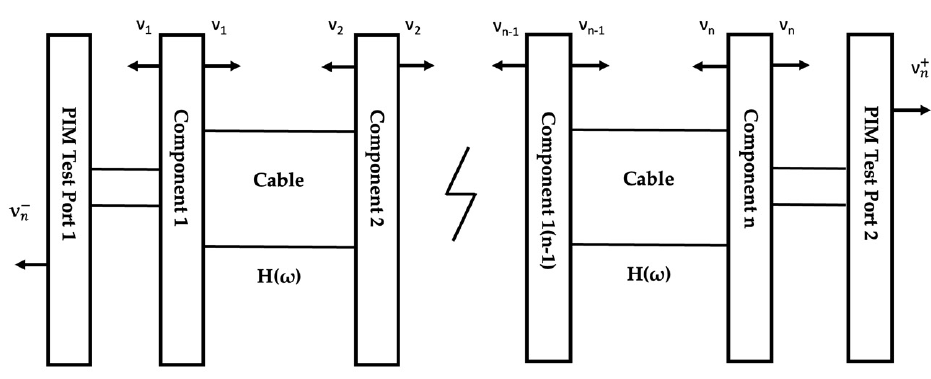
Figure 5. The general model for n − stage series